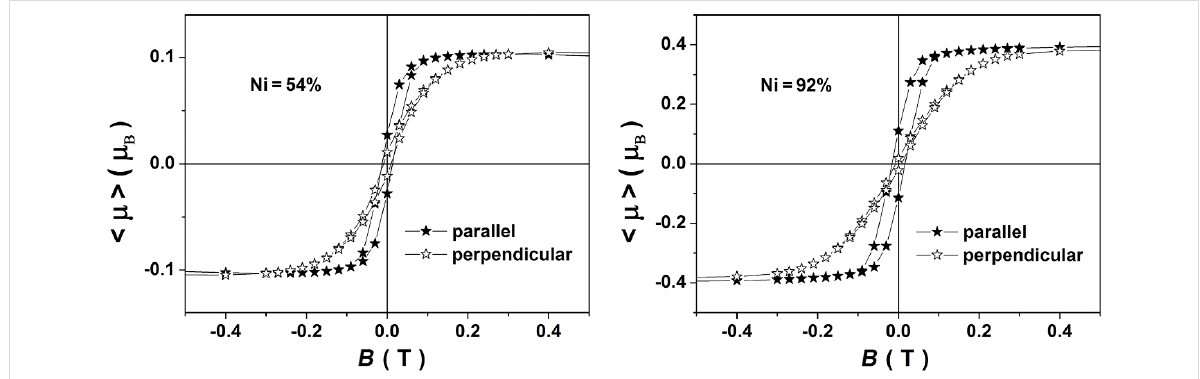
Figure 4: Hysteresis loops showing the average magnetic moment of Ni atoms as a function of the applied magnetic field, obtained from SQUID magnetometry measurements at 300 K on arrays of Ni–Cu nanowires of different compositions (54 and 92 atom % of Ni) with the field applied parallel and perpendicular to the nanowires.